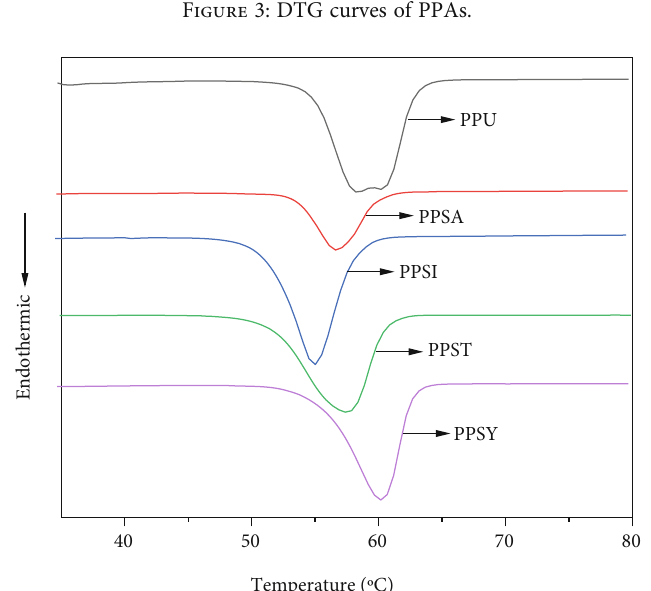
Figure 3: DTG curves of PPAs.